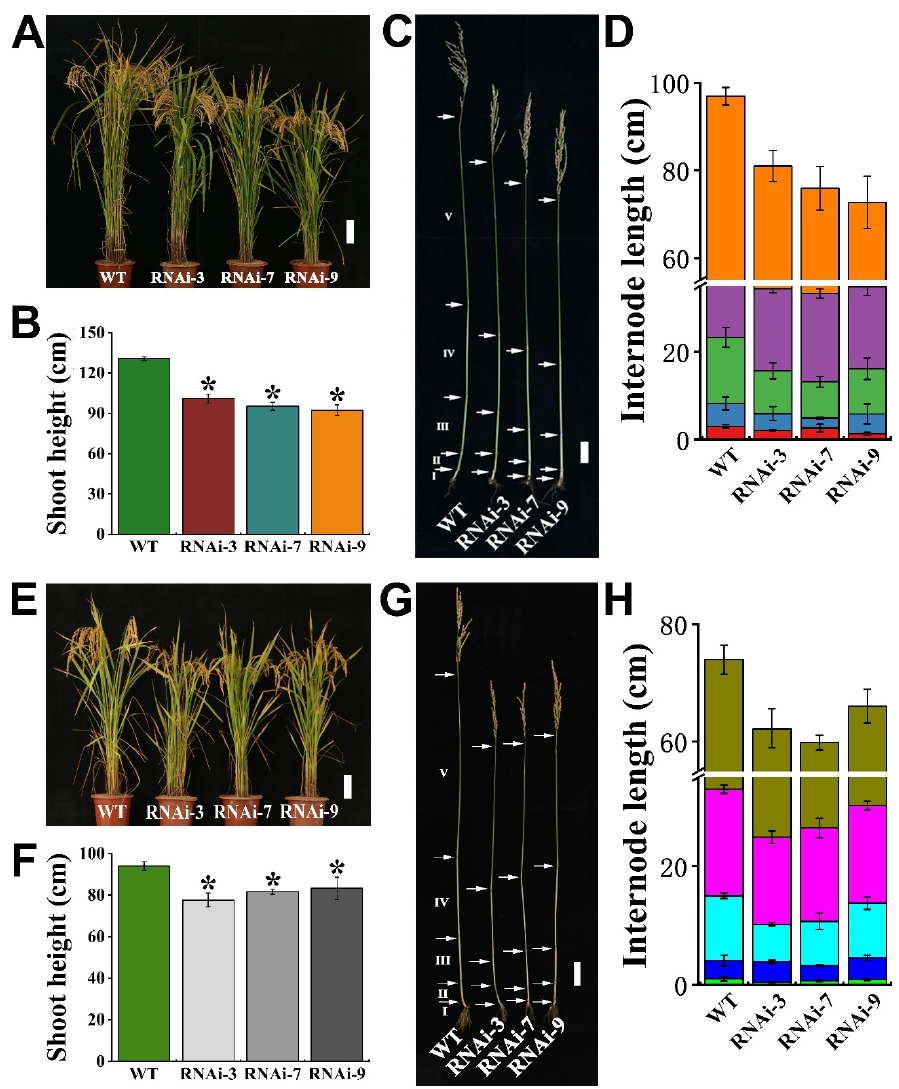
Figure 6. Variations in rice morphology and internode length of mature tissues between RNAi lines and wild-type (WT) rice grown on soil with and without Cd (for Mn trial) contamination. The rice varieties were ripened under natural conditions throughout the lifespan. ( A – D ) Rice was grown on soil without Cd and harvested to measure Mn concentrations. ( E – H ) Rice was grown in Cd-contaminated soil and sampled to measure Cd concentrations. ( A , E ) The growth phenotypes of WT and RNAi rice (Bars = 10 cm). ( B , F ) Shoot height of WT and RNAi lines. ( C , G ) Morphological culm (internode) structures of WT and RNAi (Bar = 5 cm). The arrow indicates the node position. ( D , H ) Quantitative analysis of internode elongation. Error bars indicate the means ± standard deviations of three independent biological replicates. Asterisks indicate that the mean values of three replicates are significantly different between WT and RNAi lines ( p < 0.05).